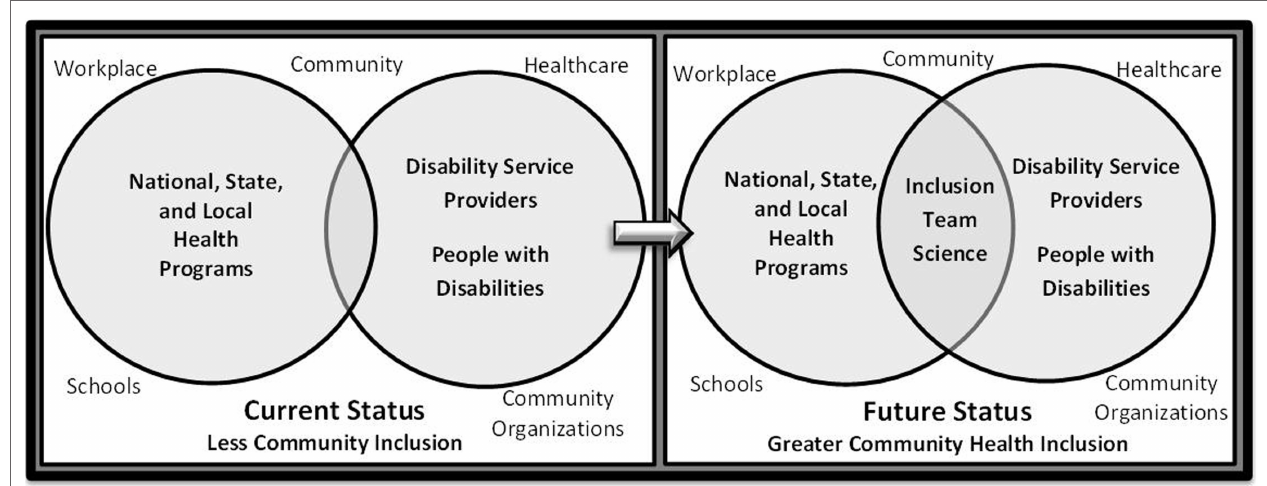
FiGUre 1 | current and Future status of community Health inclusion .